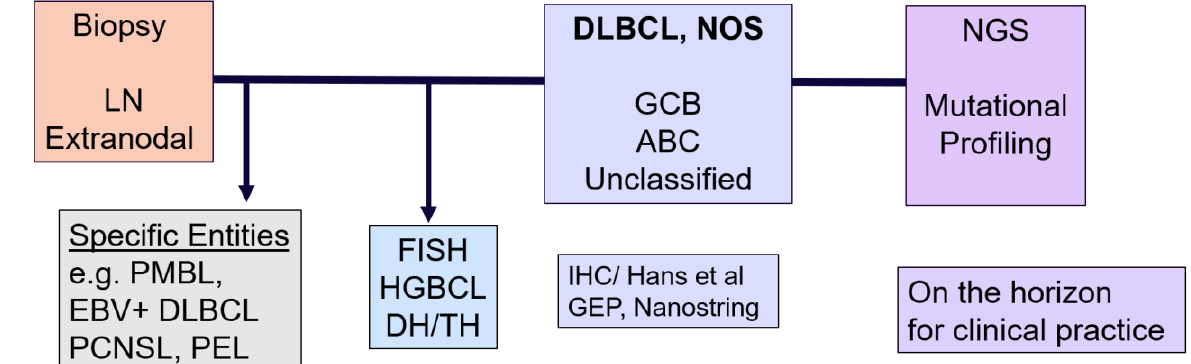
Figure 5. Aggressive B-cell lymphomas. Modified and adapted from Swerdlow et al. [3].